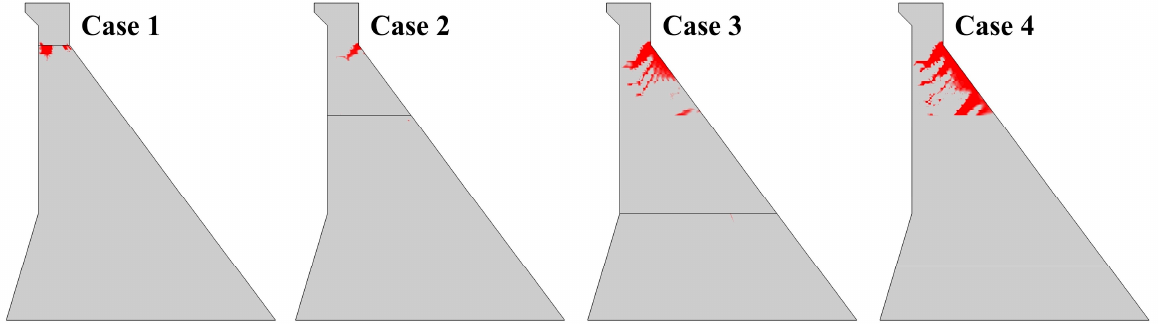
Figure 19. Damage characteristics of the dam with a well-bonded layer.